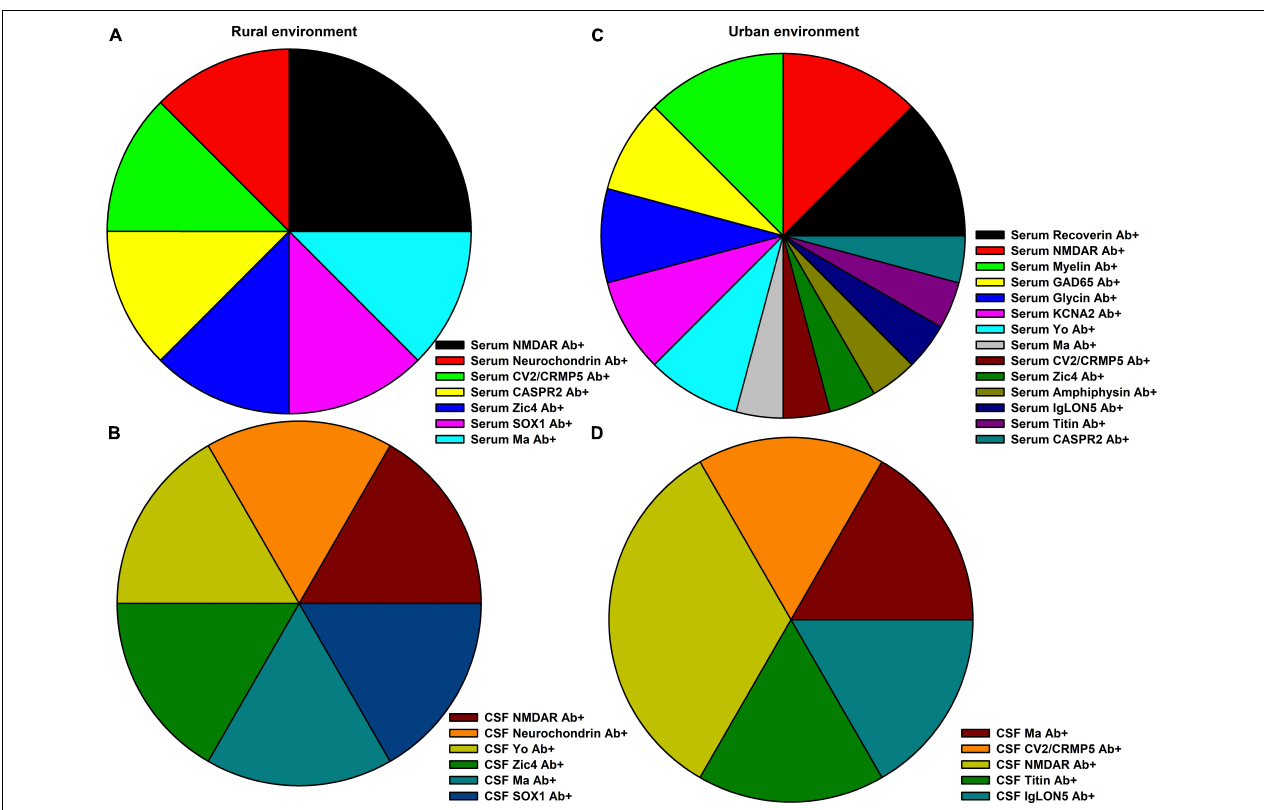
FIGURE 1 | Neural autoantibody spectrum in rural and urban environments. (A) The spectrum of serum and (B) of cerebrospinal fluid (CSF) neural autoantibody occurrence in psychiatric patients (pAb+) in a rural environment are depicted, whereas (C) the spectrum of serum and (D) of CSF neural autoantibodies in an urban environment are shown.